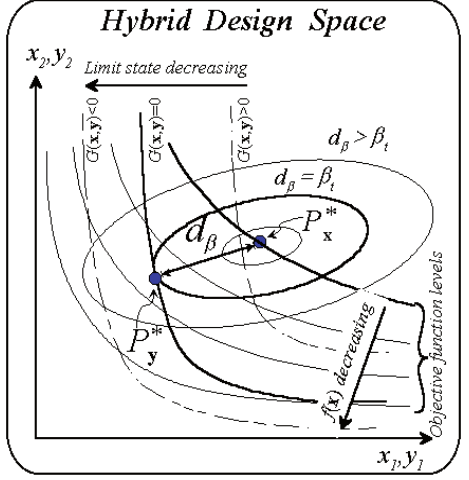
Fig. 2. Hybrid design space for normal distribution.